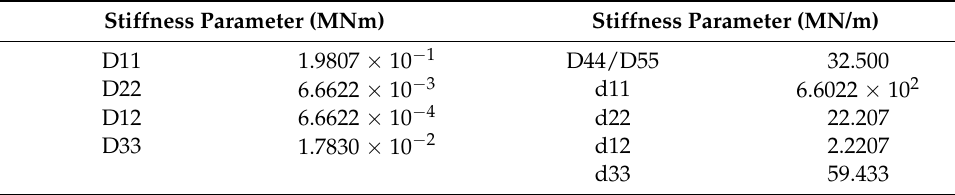
Table 2. Parameters of orthotropy for the inner layer (60 mm) of the CLT 140-3. Stiffness Parameter (MNm) Stiffness Parameter